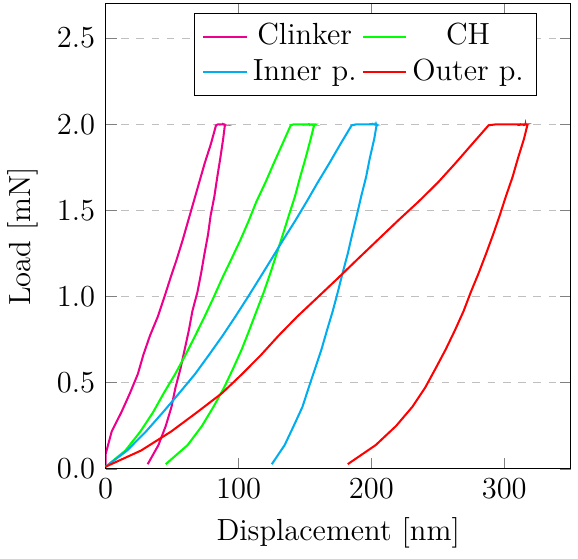
Figure 2. Typical load-displacement